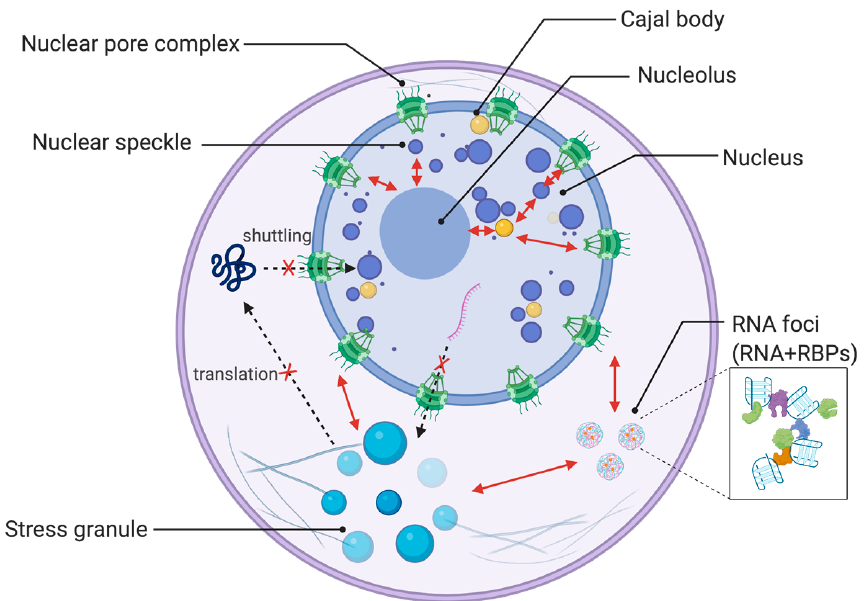
Figure 1. Membrane-less organelles that are affected by amyotrophic lateral sclerosis (ALS)-related RNA-binding proteins. Membrane-less organelles described in this review are illustrated, including the nucleolus, nuclear speckle, Cajal body, stress granule, along with RNA foci and nuclear pore complex. Dysregulation of RNA-binding proteins (RBPs) such as ALS-causing mutations leads to abnormal dynamics and function of the nucleolus, nuclear speckles, Cajal bodies, and stress granules. This dysfunction of membrane-less organelles is also interconnected to nucleocytoplasmic shuttling and RNA foci that may sequestrate RNA-binding proteins. These ALS-related cellular abnormalities influence each other. Created with